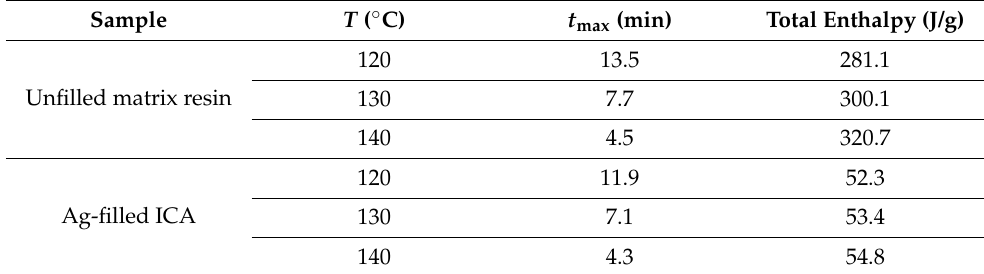
Figure 1. Isothermal DSC curves and conversion curves of the unfilled matrix resin ( a , b ) and the Ag-filled ICA ( c , d ). Table 1. Isothermal data of the Ag-filled ICA and its unfilled matrix